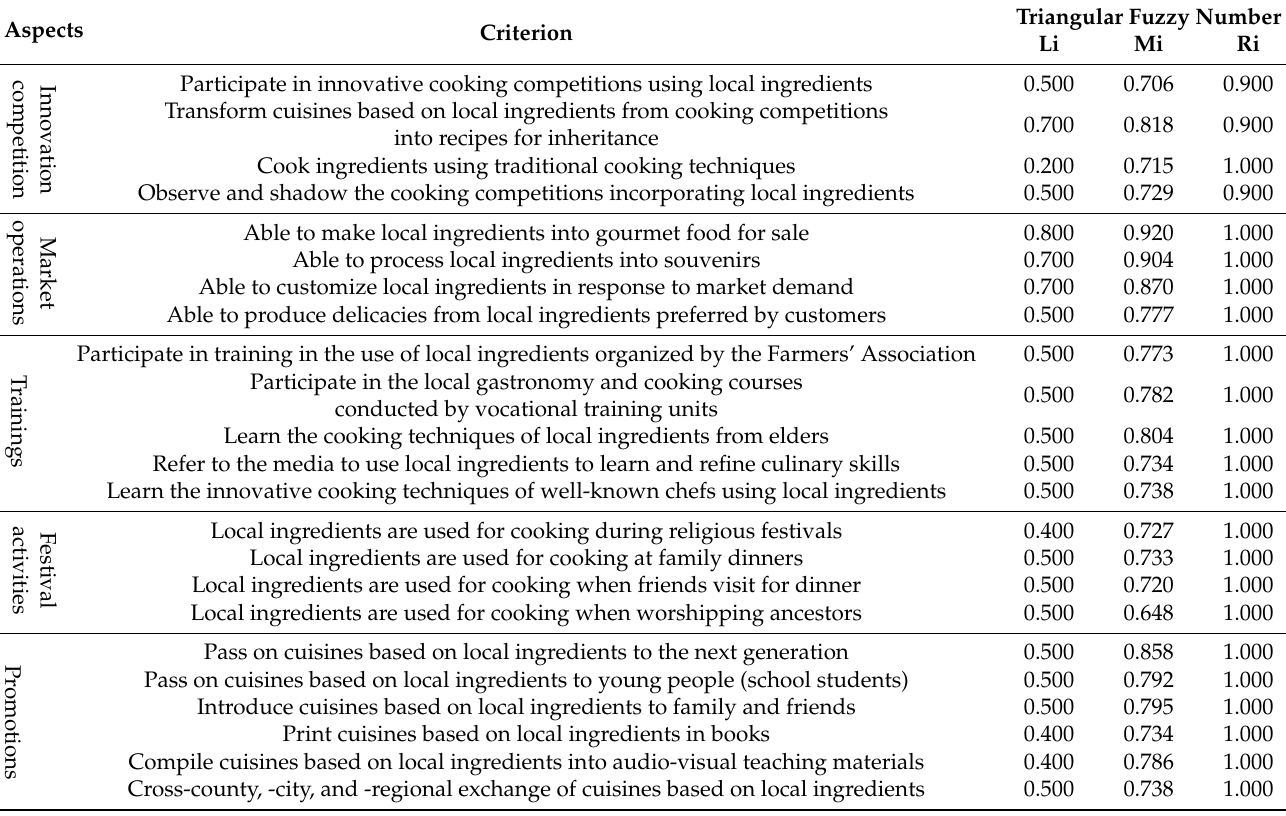
Table 3. Triangular fuzzy number analysis table for various agricultural